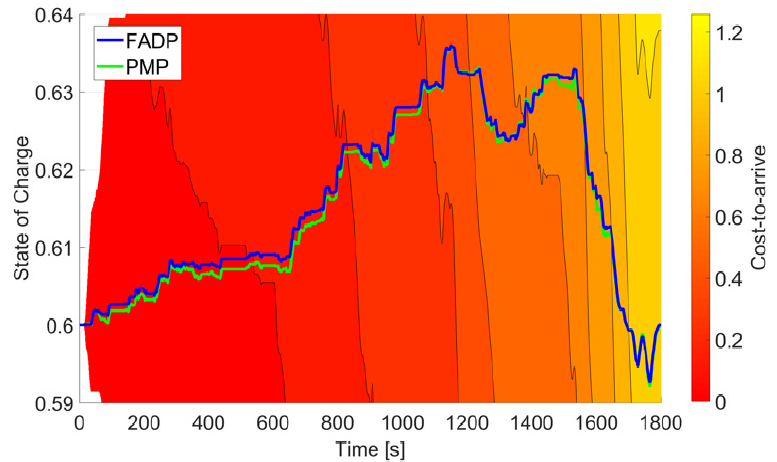
Figure 5. Cost-to-arrive map and optimal state trajectories obtained with FADP optimizations on the